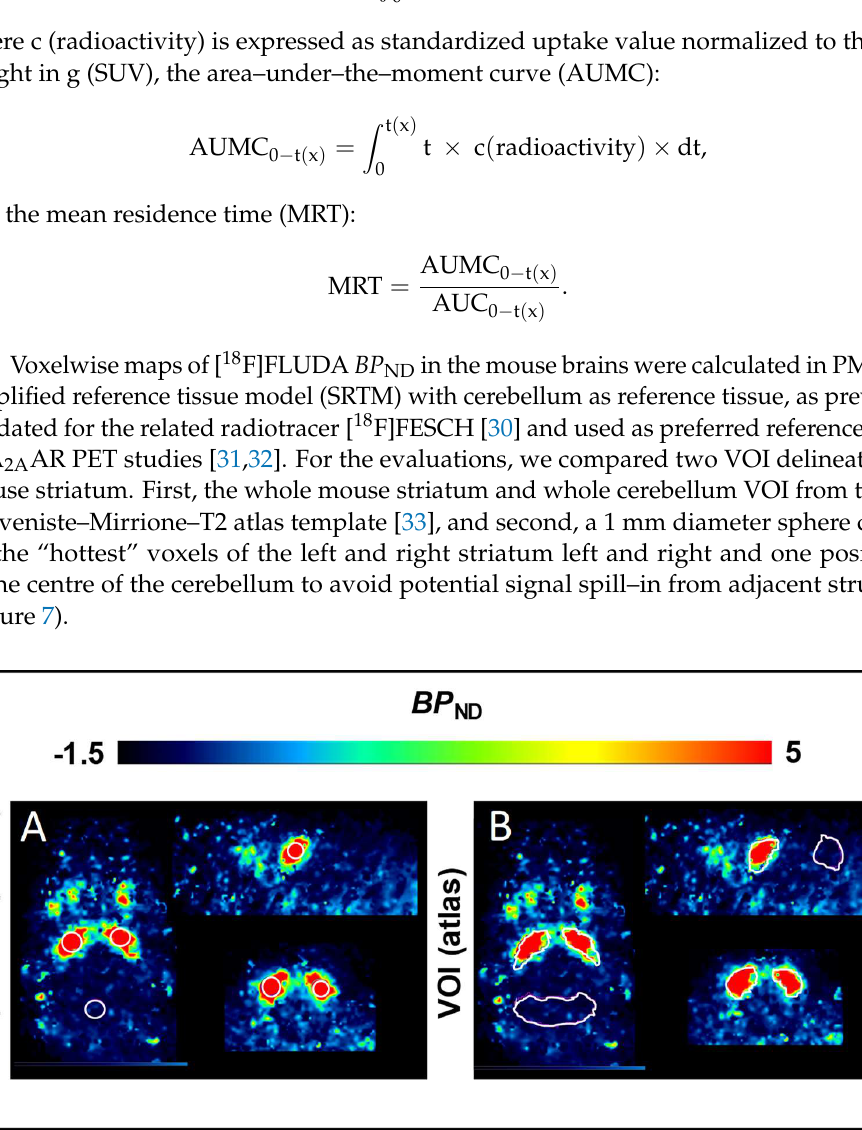
Figure 7. Example of the placement of the volume of interest in mice analysis for ( A ) the 1 mm diameter sphere VOI delineation and ( B ) for the Ma–Benveniste–Mirrione–T2 atlas template delineation of the striatum and cerebellum regions.